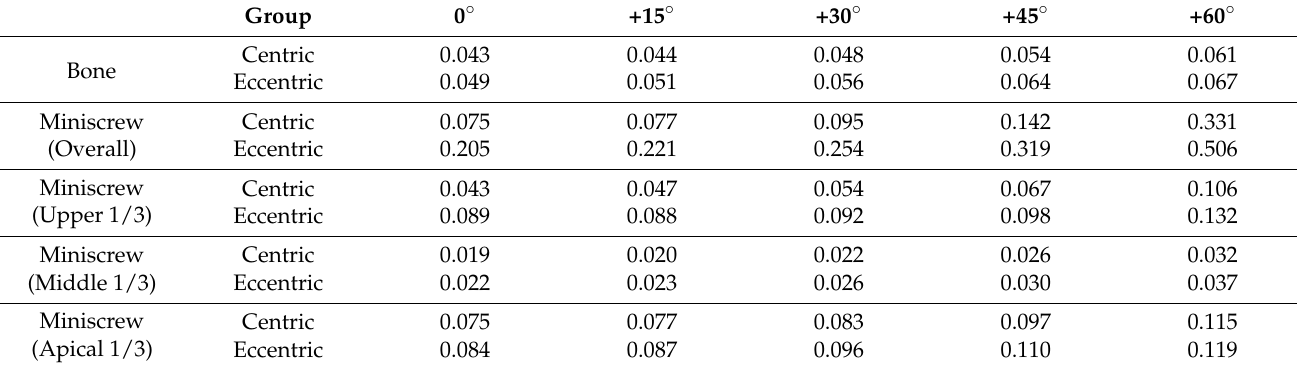
Table 2. Maximum Von-Mises stress (GPa) at the bone and each part of the orthodontic miniscrew according to the position of the hole in the head part and the positive wire insertion angles.